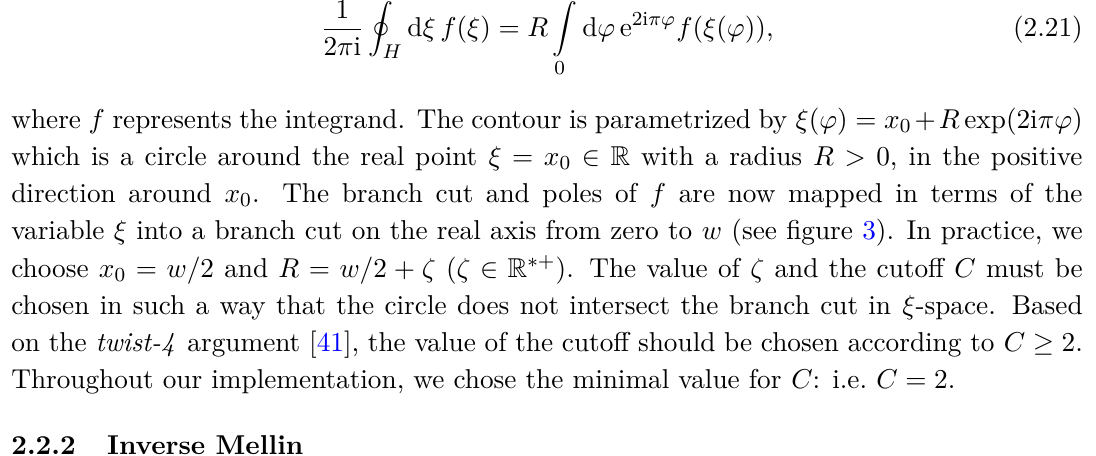
Figure 2. Singularity structures related to the Landau pole and the Minimal prescription path for the Mellin inverse integration.